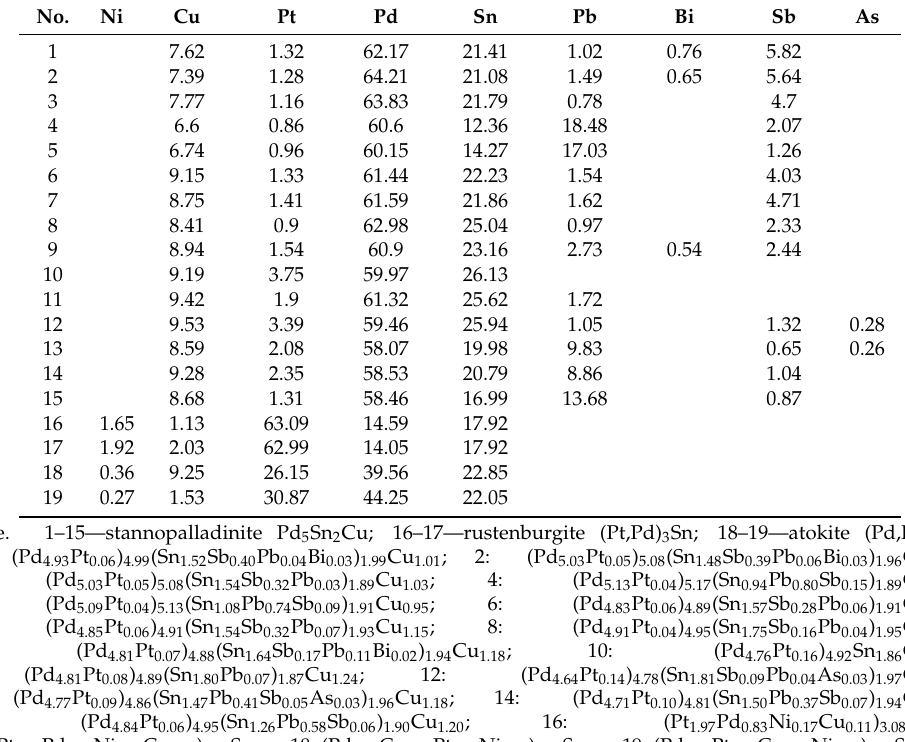
Table 6. Mineral compositions in the system Pd-Pt-Cu-Sn from the Southern 2 orebody, wt %. No.